Question: Which kind of chart has been used to present this data?
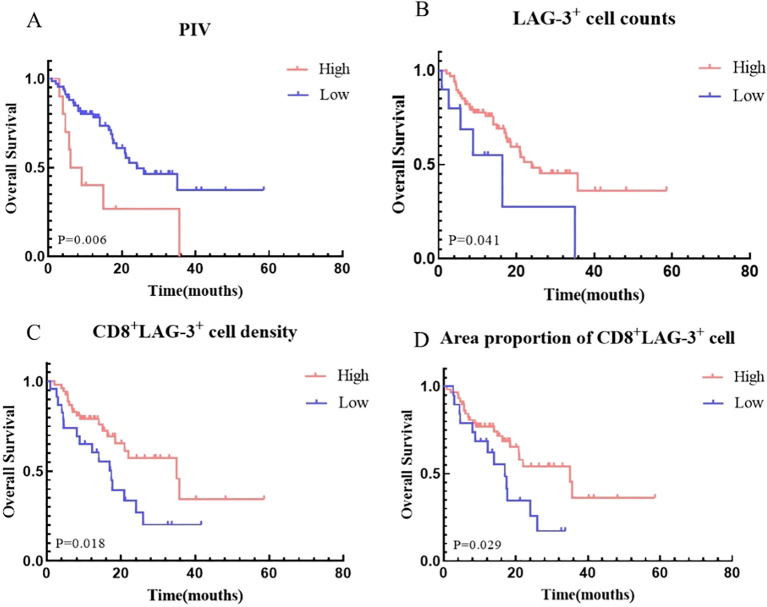
Answer: survival